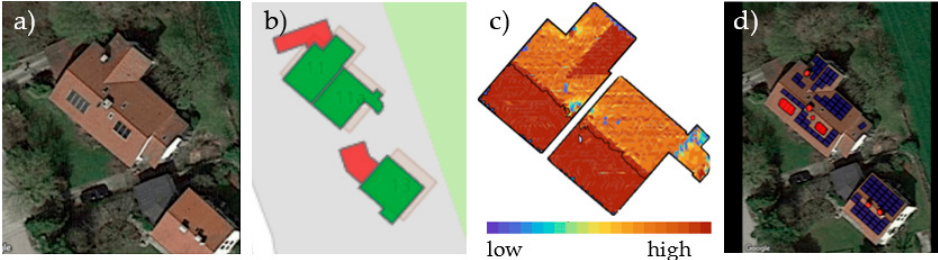
Figure 8. Image ( a ) google maps aerial image, ( b ) solar potential map screenshot, ( c ) merged building outlines from solar potential map, ( d ) merged radiation visualization from solar potential map.